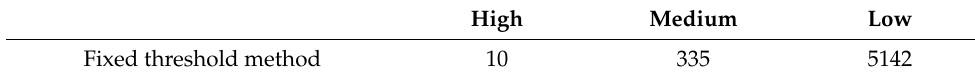
Table 12. Suspicion level of fixed threshold identification results.